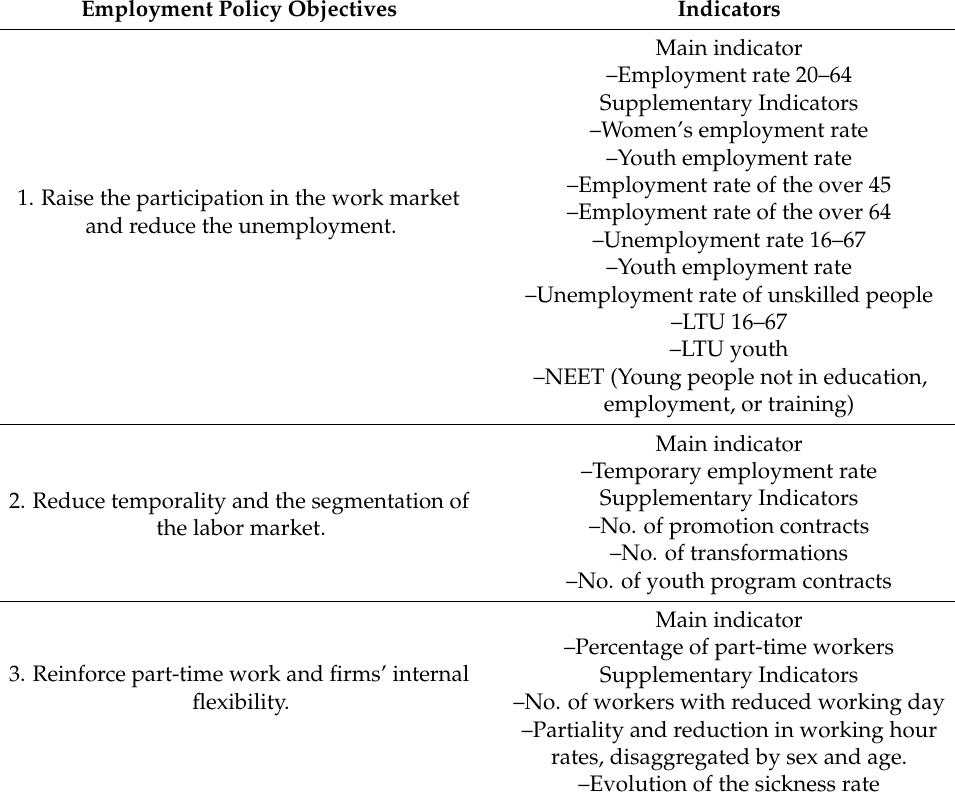
Table 2. Indicators of monitoring and evaluation of the degree of fulfillment of the employment policy